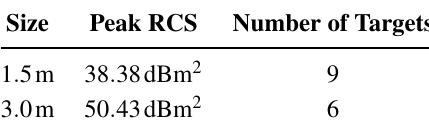
Corner reflectors with two different inner-leg lengths were used during the